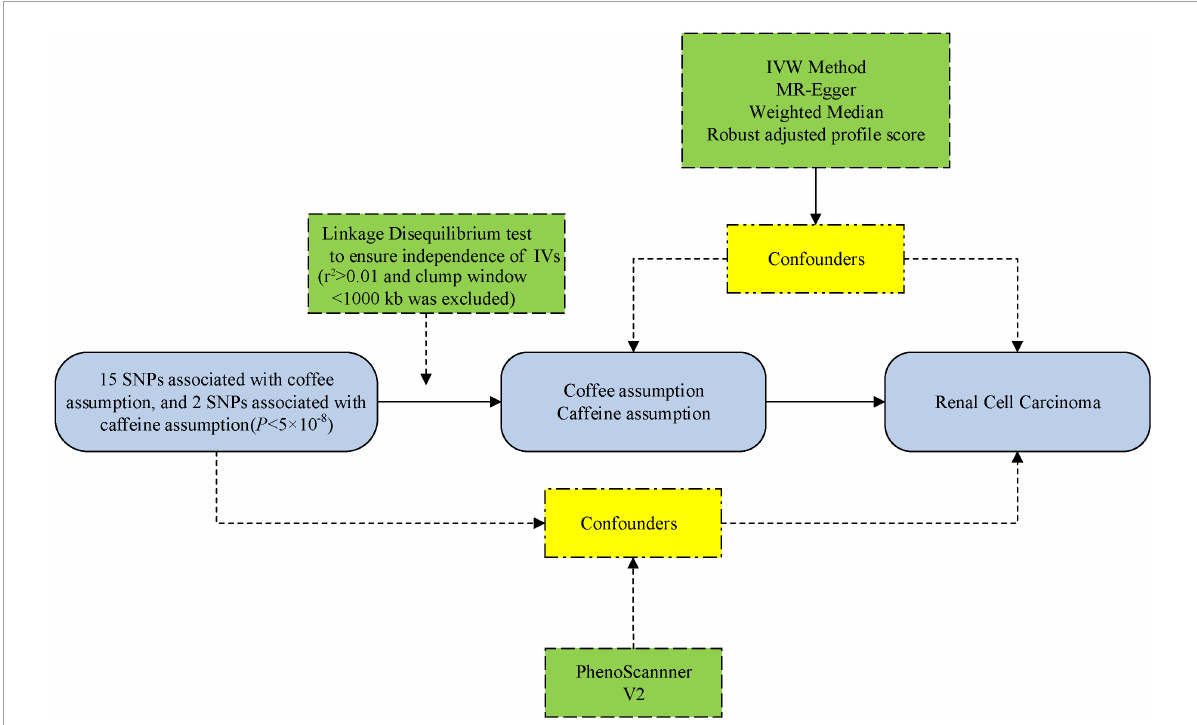
FIGURE1 The flowchart of the Mendelian randomization (MR) study. IVs, instrumental variables; SNP, single nucleotide polymorphism; IVW, inverse-variance-weighted.